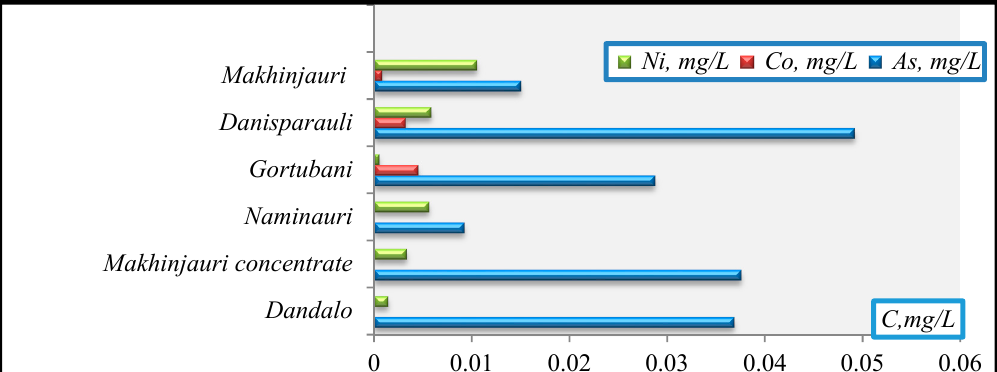
Figure 13. The content of Co, Ni and As in the mineral waters.